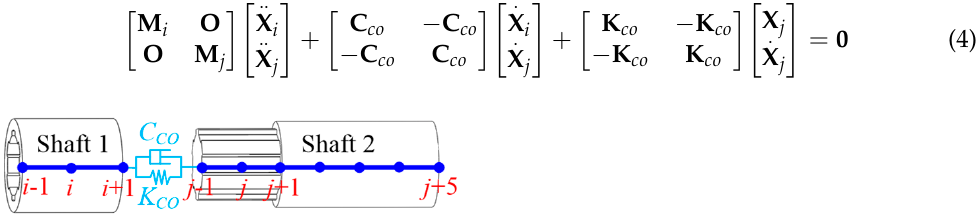
Figure 6. Equivalent model of connecting elements.